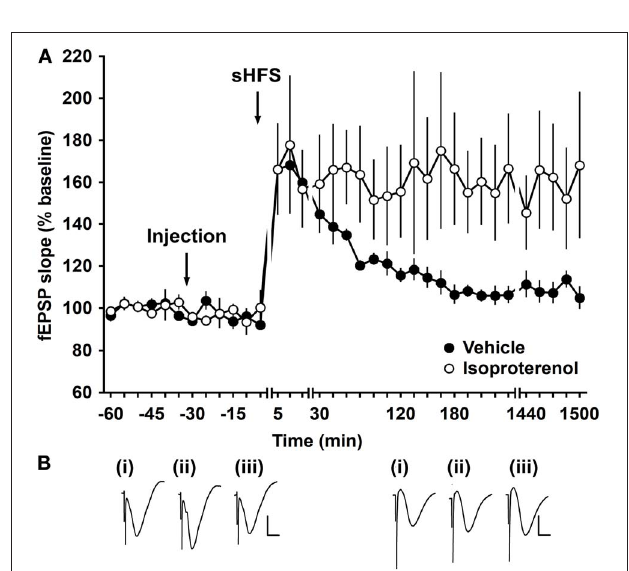
FIGURE 7 | Continued underwent exploration of novel landmarks, and bottom row shows fEPSPs evoked in propranolol-treated animals that underwent exploration of novel landmarks. Vertical scale bar: 2mV, horizontal scale bar: 6msec. (D) Analog traces recorded during experiments shown in (B) , 5min pre-sLFS (i), 5min post-sLFS (ii), and 24h post-sLFS (iii). The top row represent analogs from a vehicle-treated animal that underwent a second exposure to the landmarks, middle row depict fEPSP responses from a first re-exposure experiment (in an animal formerly treated with propranolol) and the bottom row represent responses of fEPSPs recorded during the second re-exposure experiment (in an animal formerly treated with propranolol). Vertical scale bar: 2mV, horizontal scale bar: 6ms.